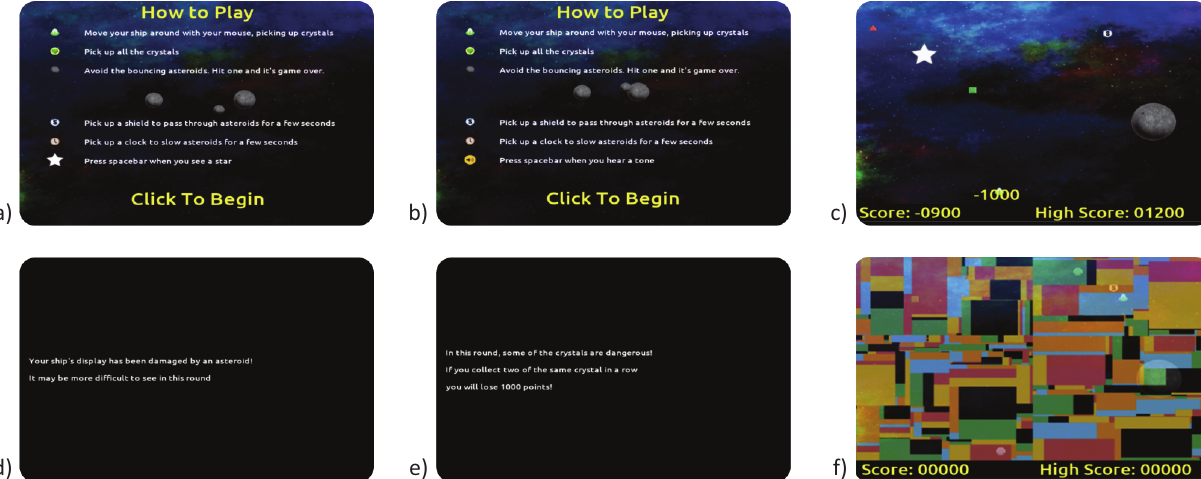
Figure 1. Depiction of the main screens in the game environment. a) Instruction screen for the visual modality condition; b) instruction screen for the auditory modality condition, c) depiction of the cognitive load manipulation, d) depiction of the instruction screen preceding the cognitive load manipulation, e) depiction of the instruction screen preceding the per- ceptual load manipulation, f) depiction of the perceptual load manipulation. Under perceptual load, randomly generated Mondrian-type squares were overlaid onto the screen at 80% opacity, rendering game elements much more difficult to see. In the cognitive load condition, collection of two of the same-colored crystal in a row would cause a loss of 1000 points (equivalent to ten